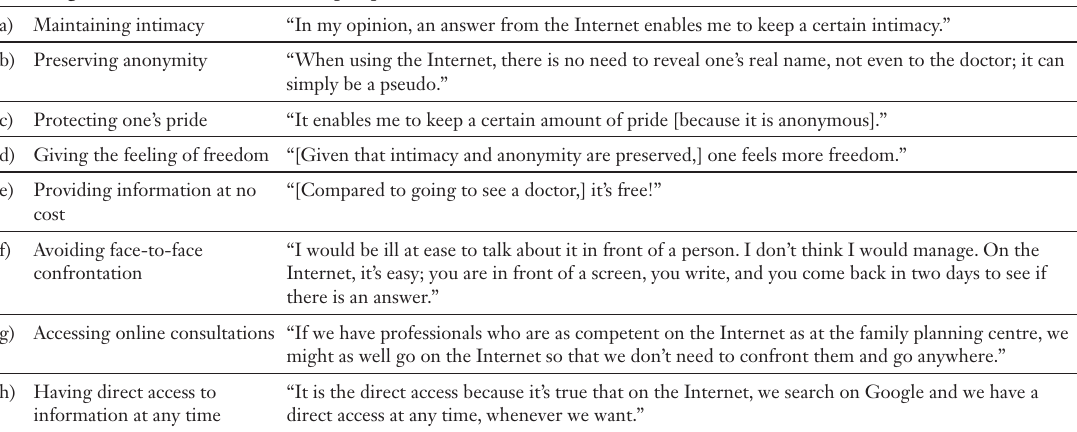
Advantages of the Internet compared to any other offline consultation form and example quotes from the